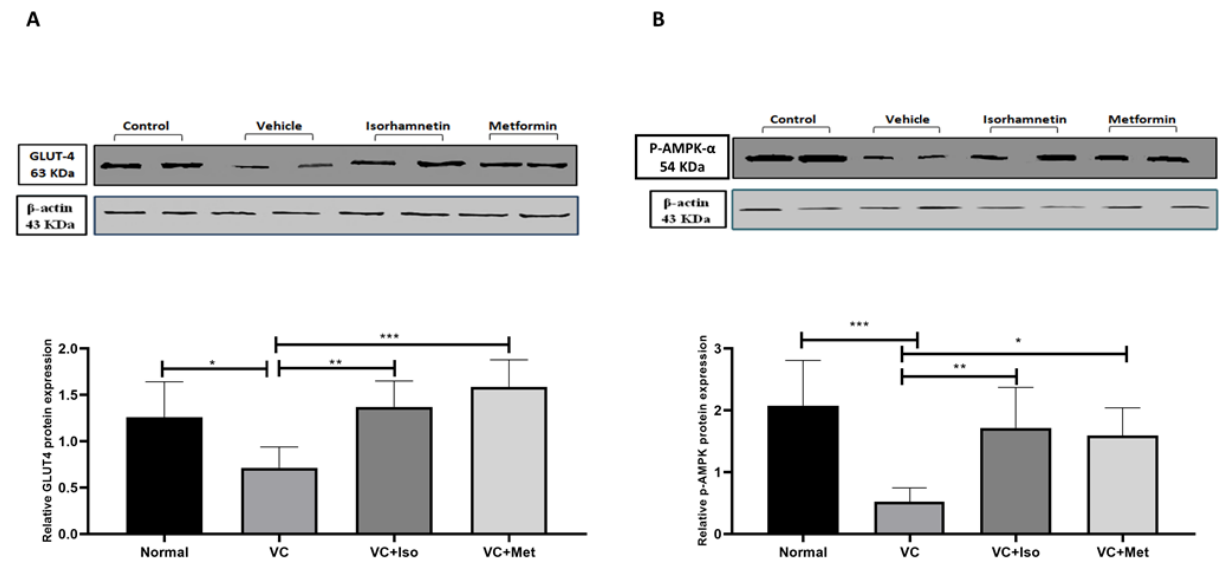
Figure 4. Isorhamnetin upregulated GLUT4 and p-AMPK- α expression in soleus muscle. Isorham- netin significantly upregulated GLUT4 ( A ), and AMPK ( B ) expression in diabetic mice. Mice were fed with HFD for 8 weeks followed by two low doses of STZ injection (40 mg/kg), after diabetes confirmed, mice were treated with 10 mg/kg isorhamnetin or 200 mg/kg metformin for 10 days, mice were then sacrificed, and soleus muscle was isolated and homogenized before western blotting performed. One-way ANOVA followed by Tukey post hoc, * p < 0.05, ** p < 0.01, *** p < 0.001. VC; vehicle control, Iso; isorhamnetin, Met; metformin.